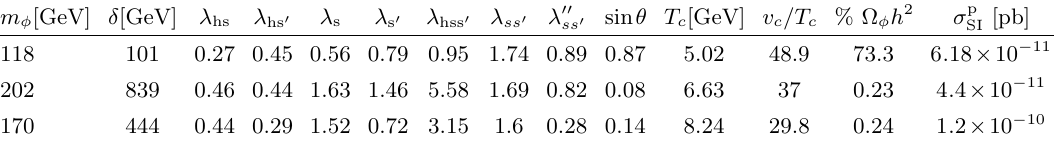
Table 3 . Benchmarks for scenario 2.2.2 in the model with the s - s 0 cross-coupling terms. is excluded by the recent direct detection (DD) bounds. One of the characteristics